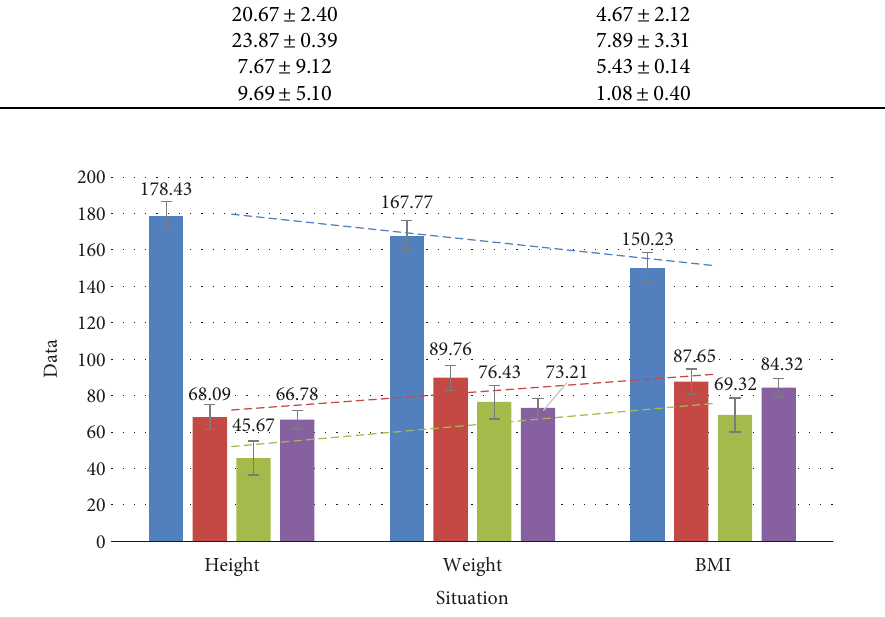
Figure 4: Comparison of VEGF content in granulation tissue of two groups before and after treatment.